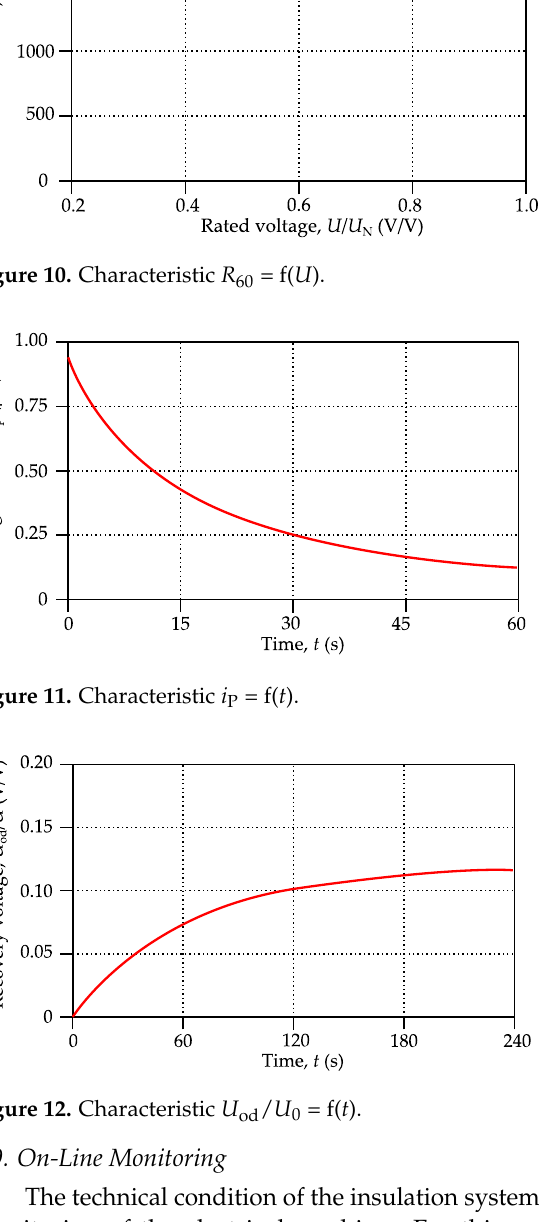
Figure 12. Characteristic U od / U 0 = f( t ).